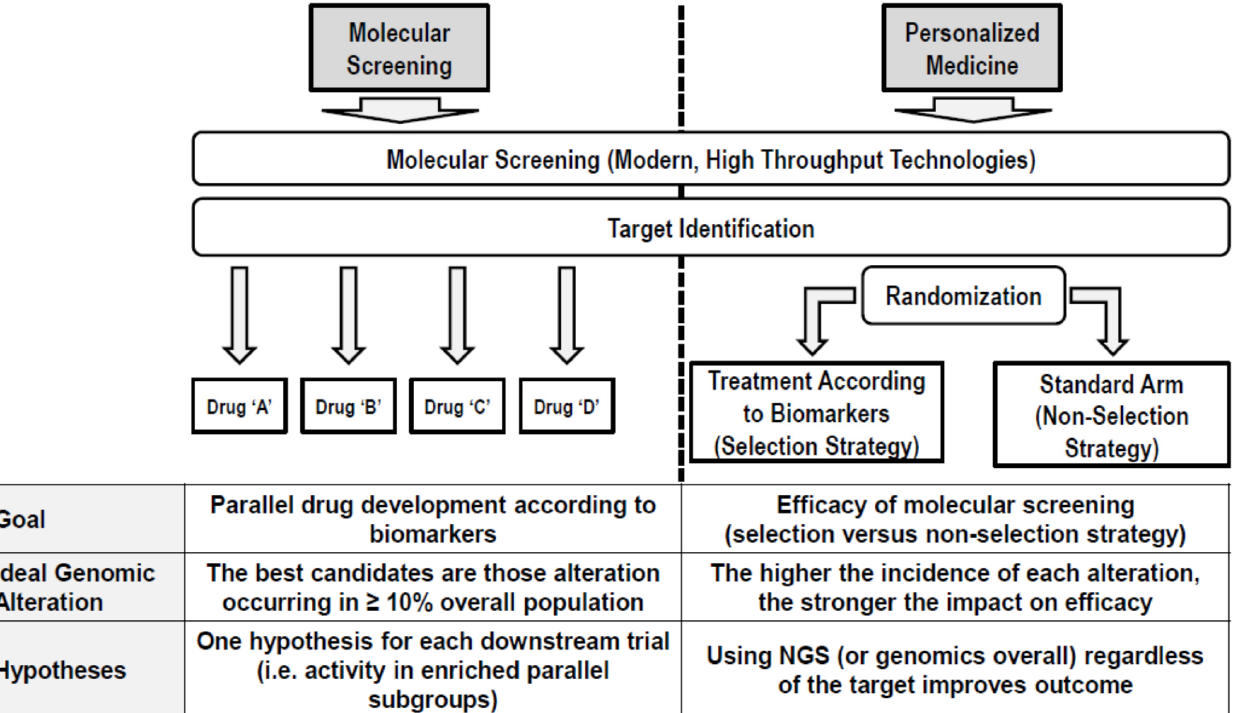
Figure 1. Efficiency of the “personalized model”.